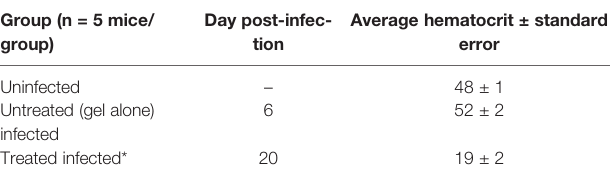
TABLE 2 | Hematocrit values of treated mice measured 2 days before their death. Group (n = 5 mice/